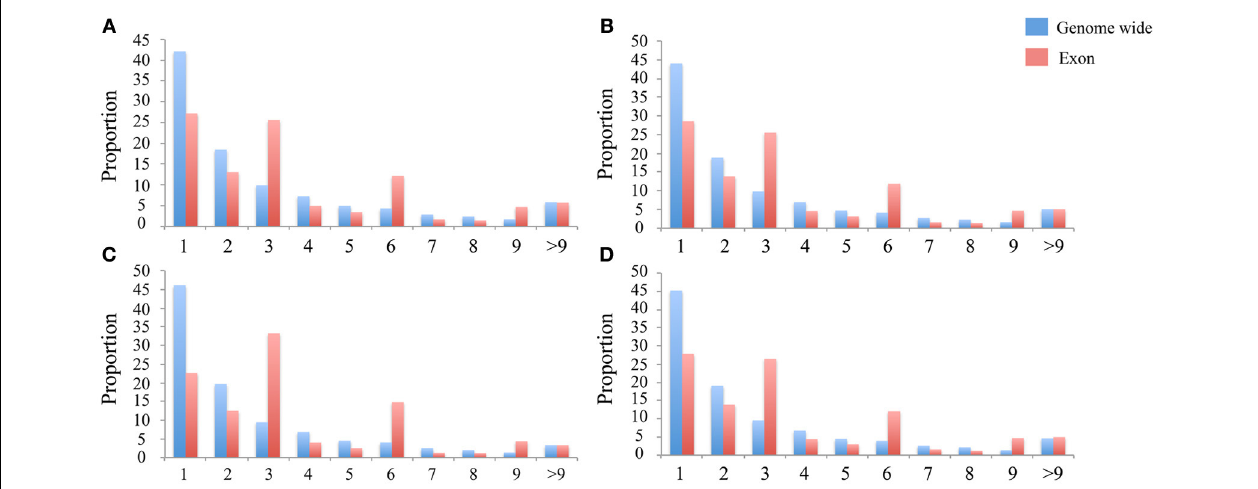
FIGURE 3 | Indel length distribution. The Y-axis is the proportion of the indels in the exon region (Red) and genome wide (Blue). The X-axis is binned by the length of the indel. (A–D) present in the indel length distribution in the N. brichardi , A. burtoni , P. nyererei , and M. zebra